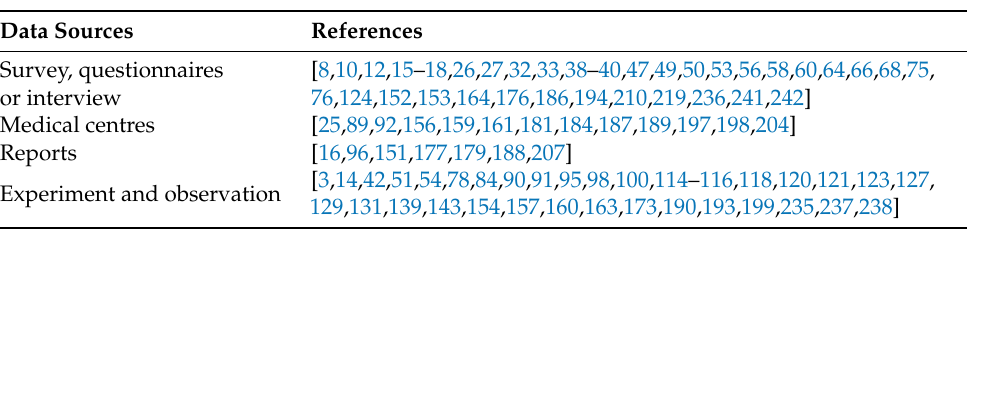
Table 6. References of previous data